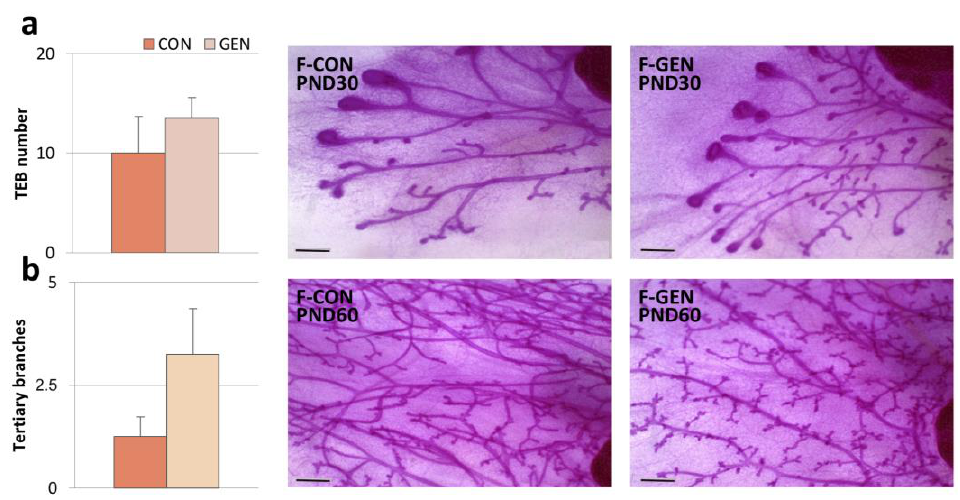
Figure 2. Mammary gland. ( a ) Histograms ( left ) and photomicrograph ( right ) showing the number of terminal end buds (TEBs) of mammary glands in control (CON) and treated (GEN) female CD1 mice at PND30. ( b ) Histograms ( left ) and photomicrograph ( right ) representing the number of tertiary branches of mammary glands in control (CON) and treated (GEN) female CD1 mice at PND60 (expressed as mean ± SEM). Scale bar = 0.5 mm.